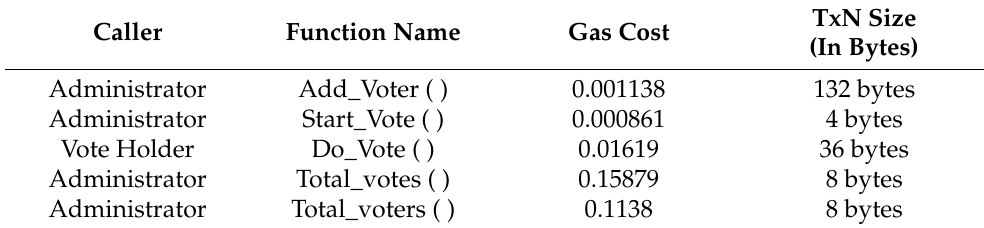
Table 2. System operations with gas cost.